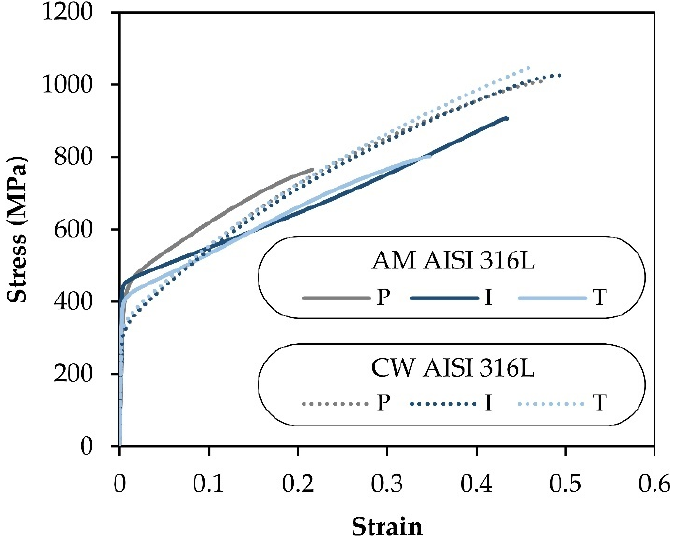
Figure 3. Flow stress of the additively deposited and wrought commercial AISI 316L stainless-steel sheets for the parallel (P), inclined (I) and transverse (T) directions with respect to the build or rolling directions, respectively. Table 2. Mechanical properties of the additively deposited and wrought commercial AISI 316L stainless-steel sheets. Material Direction Additively